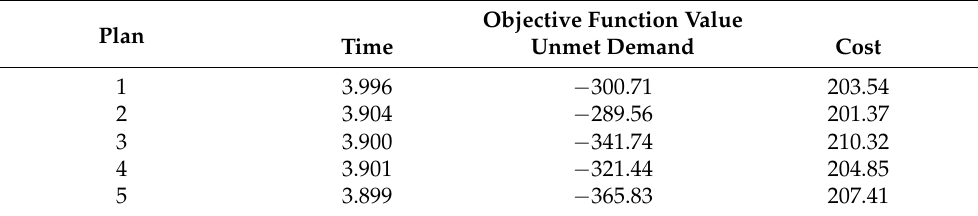
Table 11. Five groups of Pareto optimal solutions of the second stage without the multi-size